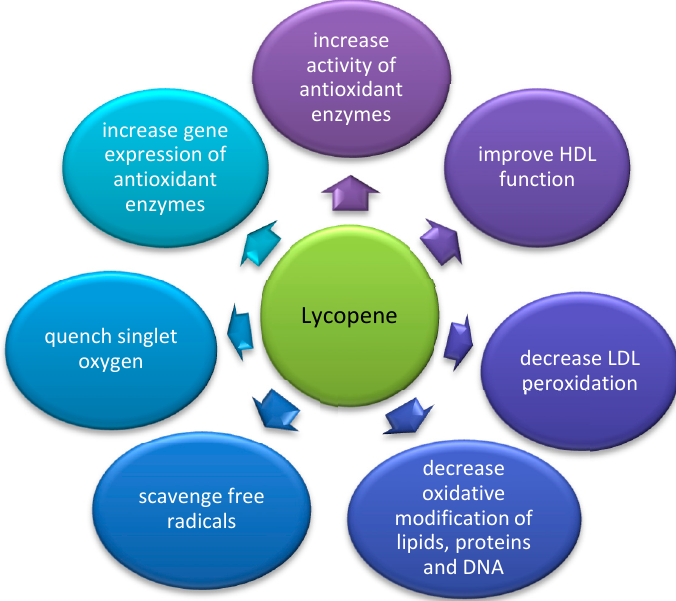
Figure 2. Proposed mechanisms of antioxidant effects of lycopene; (original figure, based on data from [77,120,142–149]).